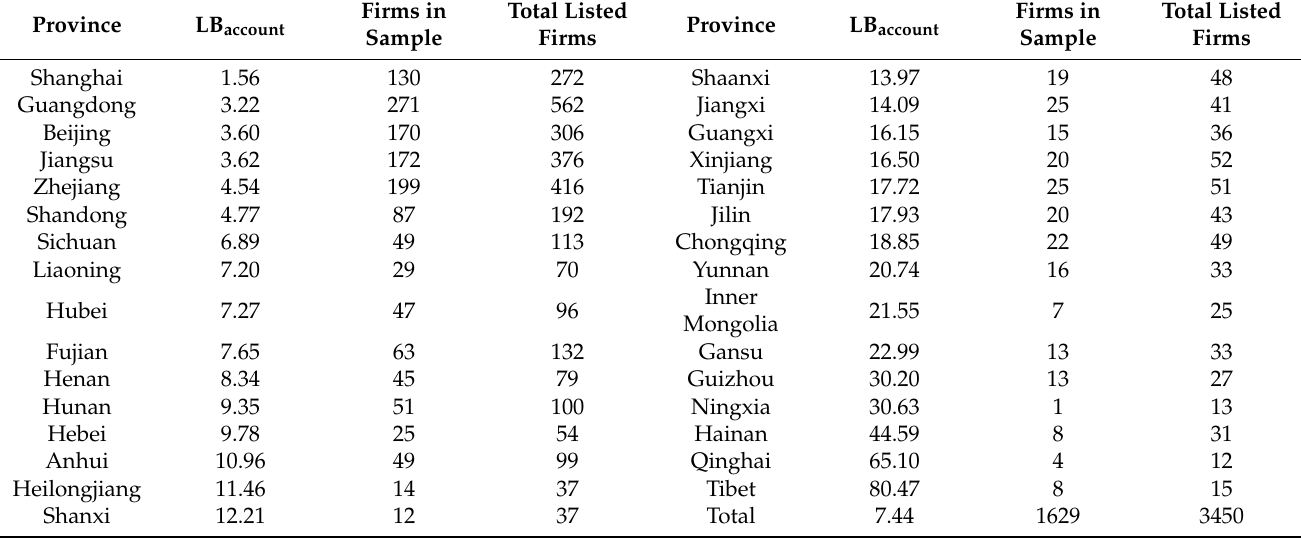
Table 3. Local Bias by